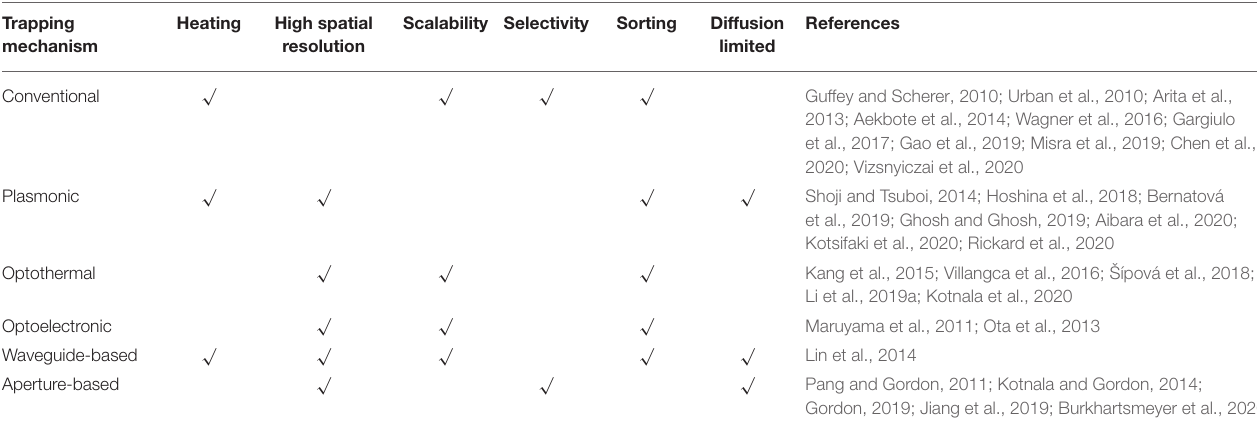
TABLE 1 | Comparison between different optical tweezers methodologies. Trapping Heating High spatial Scalability Selectivity Sorting Diffusion mechanism resolution